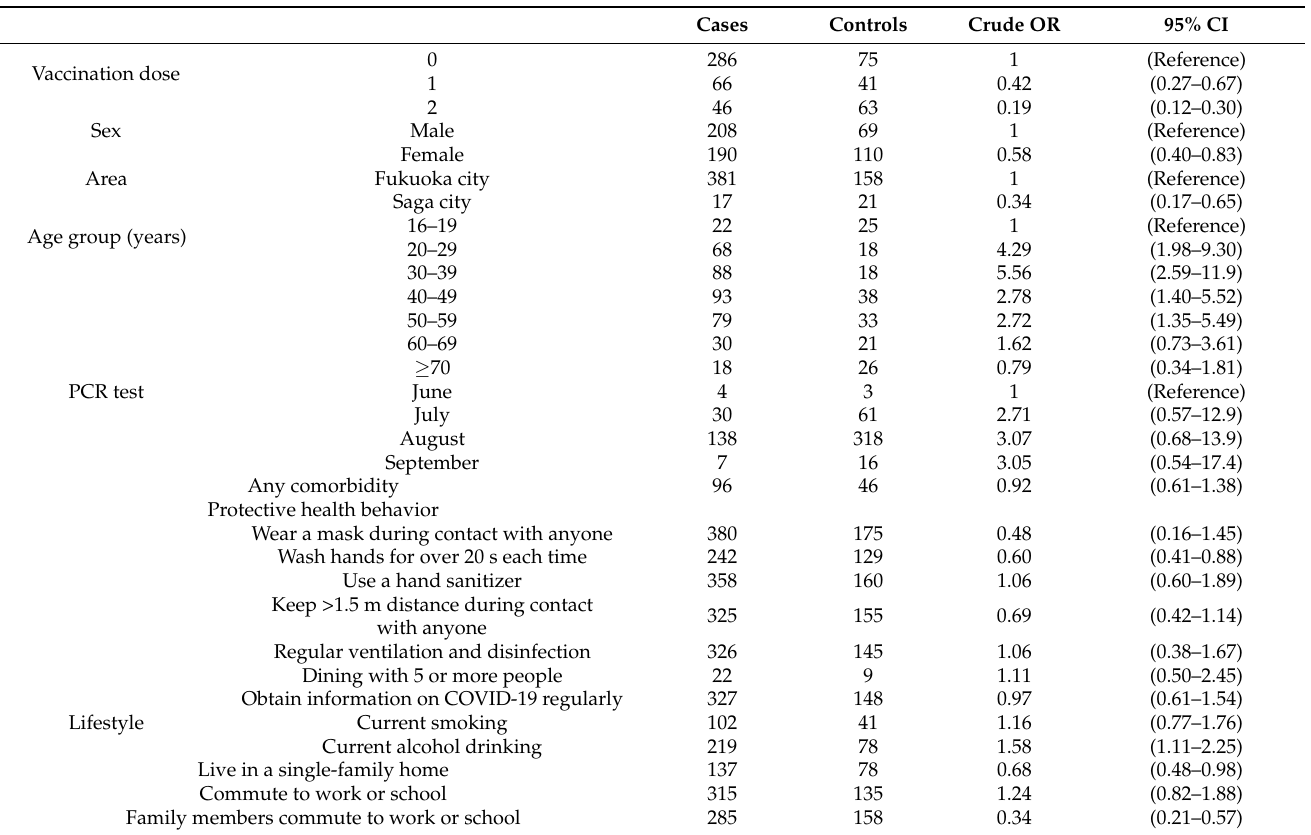
Table 3. Factors associated with COVID-19 infection in Japan, 4 June–26 September.